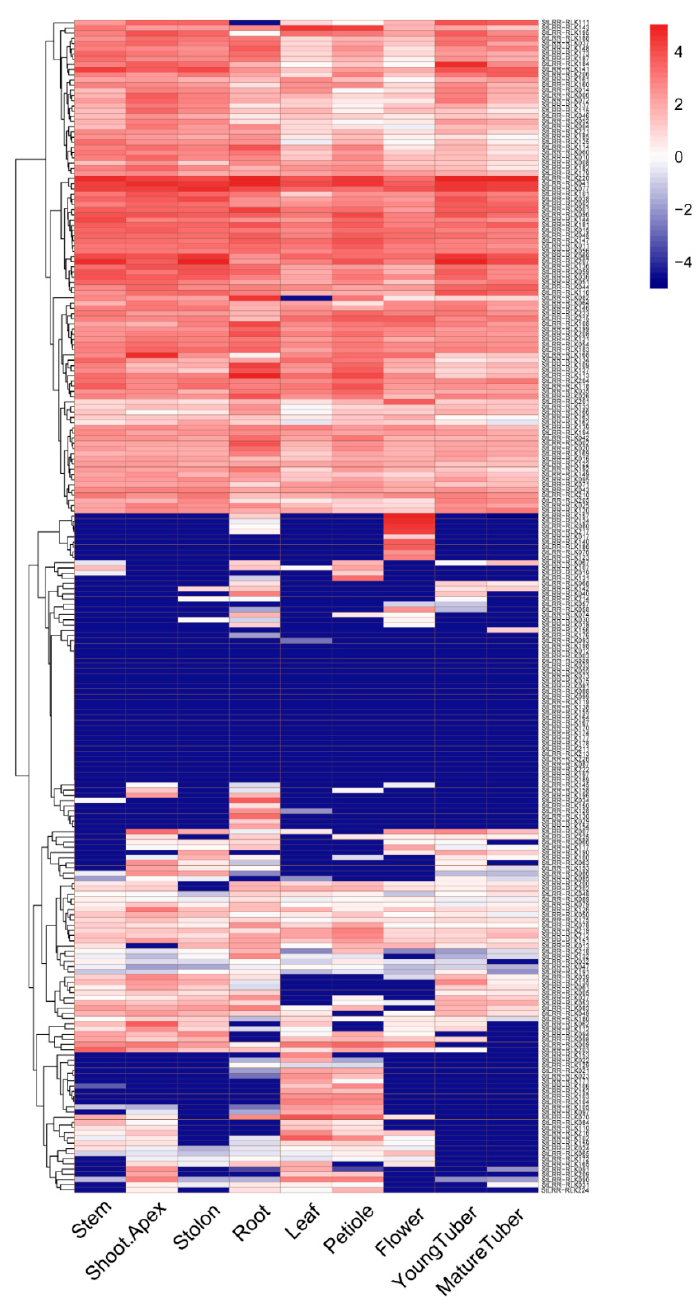
Figure 5. Expression patterns of the potato LRR-RLK family genes. The expression pattern data were normalized and visualized by R.